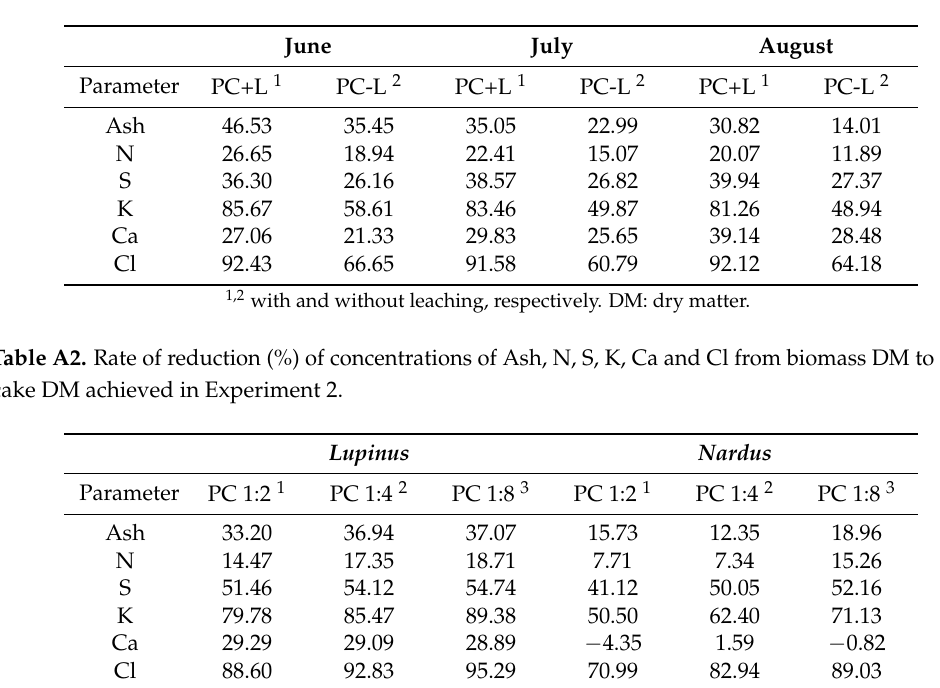
Table A1. Rate of reduction (%) of concentrations of Ash, N, S, K, Ca and Cl from biomass DM to press cake DM achieved in Experiment 1.